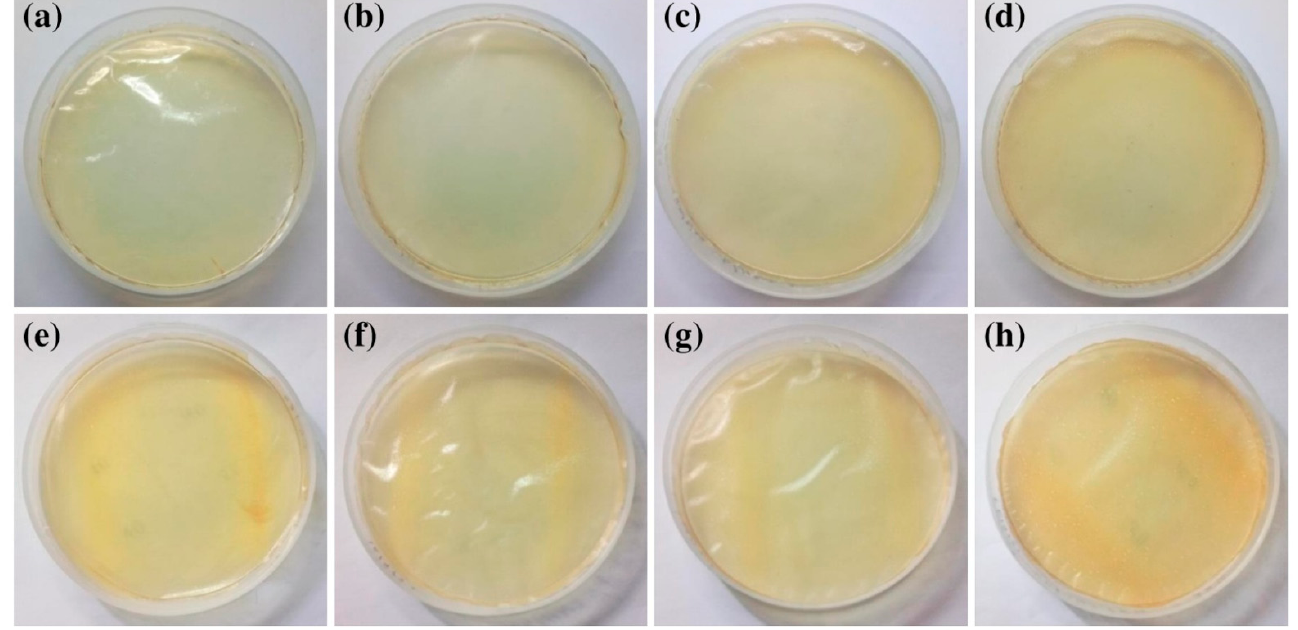
Figure 2. Representative images of nanocomposite films. ( a ) Ch film; ( b ) Ch/HNTs—5%; ( c ) Ch/HNTs—15%; ( d ) Ch/HNTs—30%; ( e ) Ch/BEO; ( f ) Ch/BEO/HNTs—5%; ( g ) Ch/BEO/HNTs—15%; ( h ) Ch/BEO/HNTs—30%.